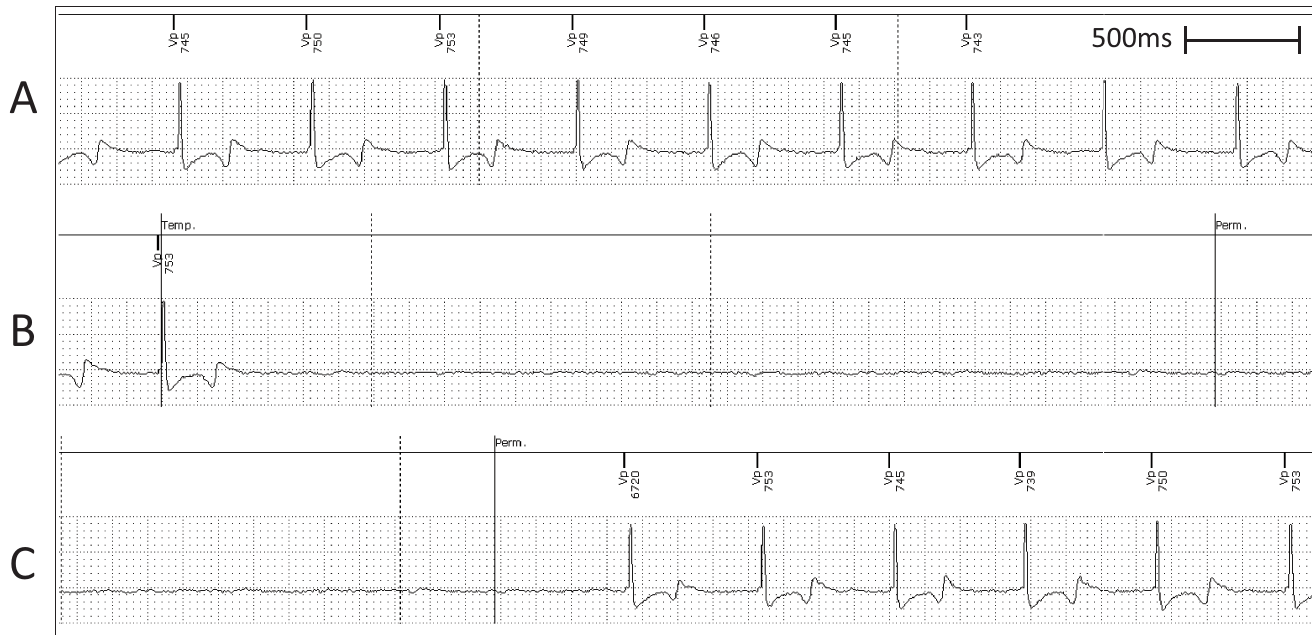
Fig 9. Lack of escape rhythm in the post-ablation follow up period. (A) Representative intracardiac ventricular lead recording depicting ventricular paced rhythm. (B) Representative lead recording showing lack of sinus rhythm when sensing feature activated by the pacemaker. Sensing period between the Temp. and Perm. lines. (C) Representative lead recording depicting return of ventricular pacing rhythm when sensing feature deactivated at Perm. line. https://doi.org/10.1371/journal.pone.0229092.g009 100% at the first follow up as the escape rhythm competed with the pacemaker device pro- grammed at 80 bpm (Fig 10). In the context of cell and gene-therapy based approaches, this outcome would not be acceptable as it would confound the result from the biological